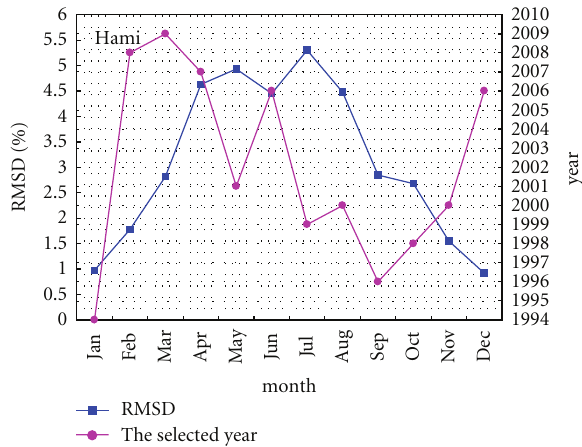
Figure 3: The minimum RMSD and the selected years for each month of the